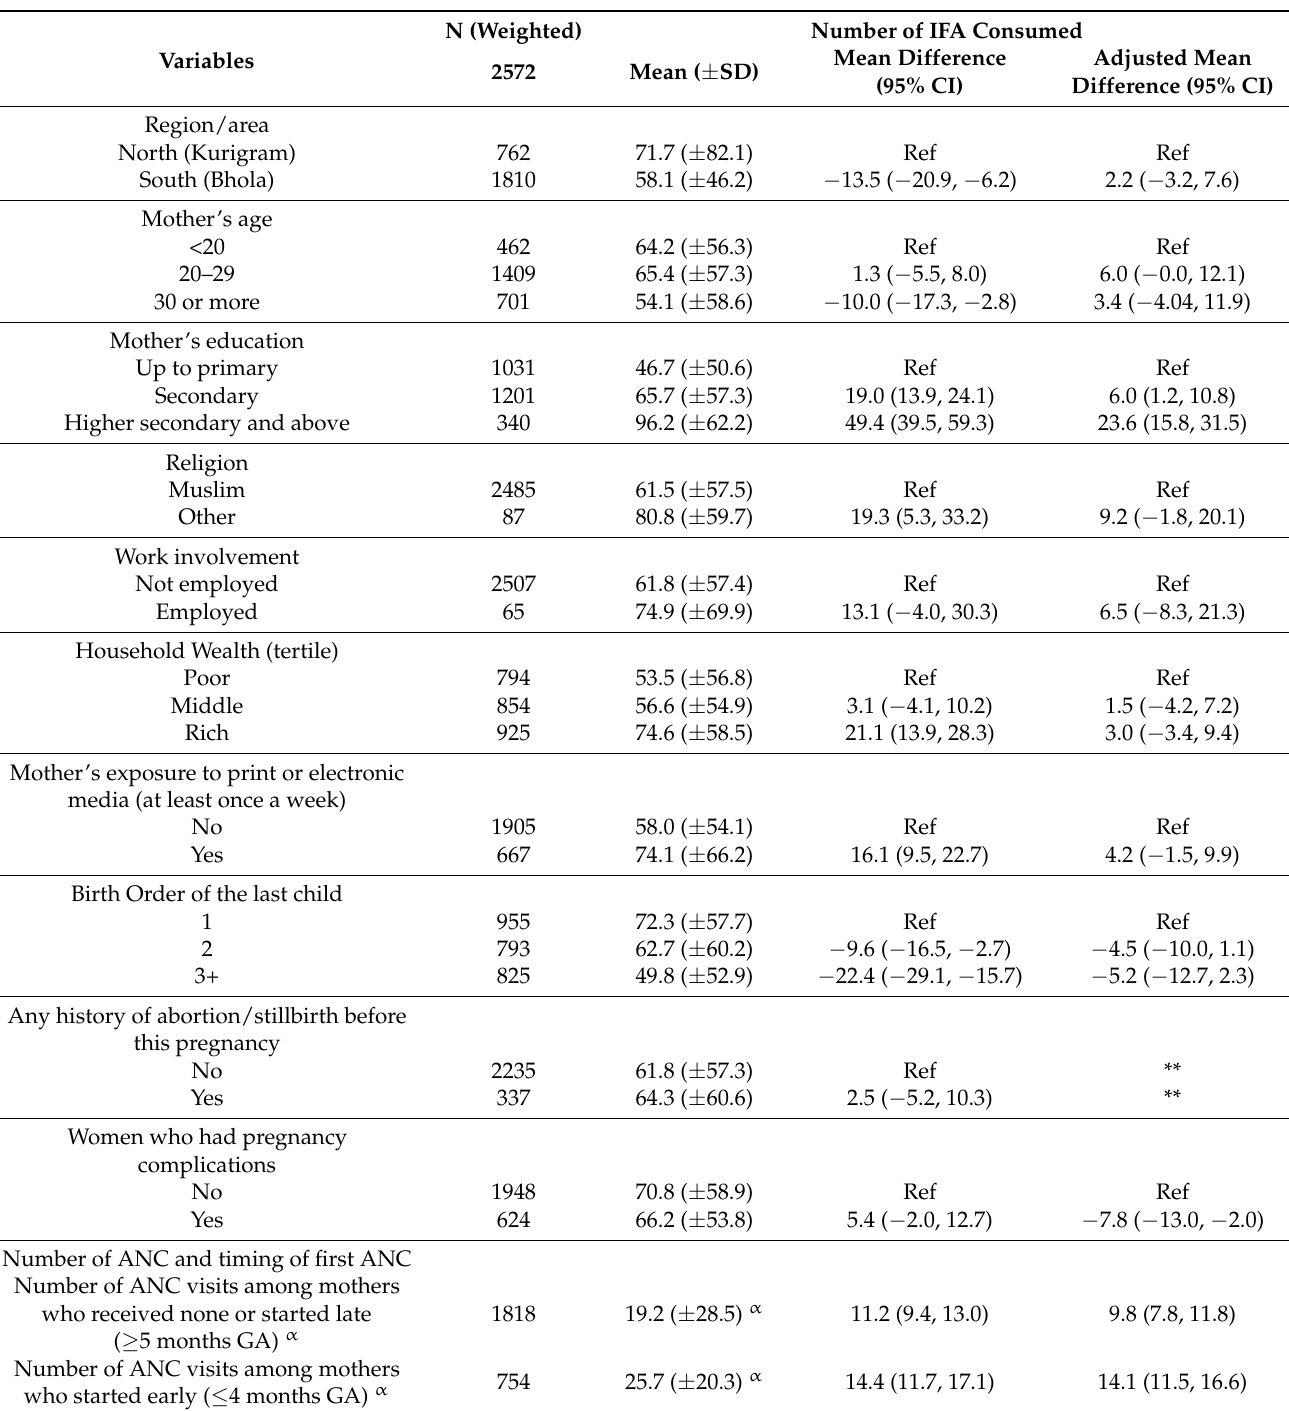
Table 3. Factors associated with the number of IFA supplements